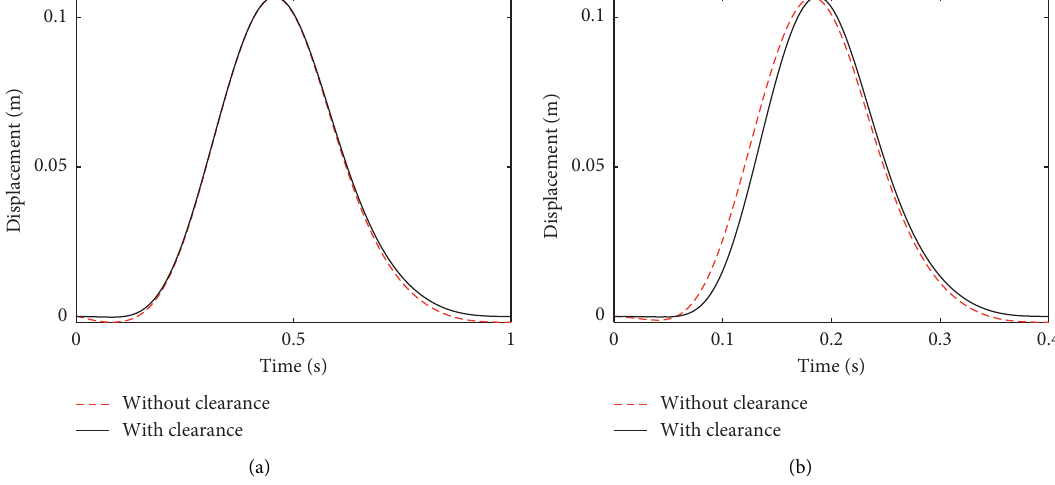
Figure 19: Displacement of the slider. (a) ω